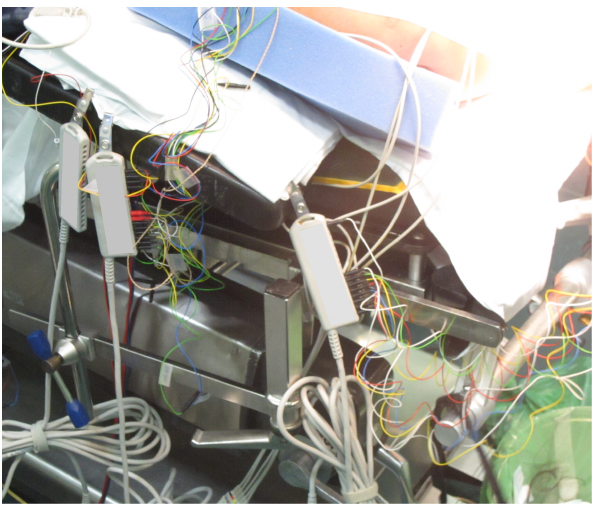
Figure 1. Example of cabling during a surgery preparation with IONM. Note the bundle of coloured cables (electrodes) and the number of adapters of the monitoring